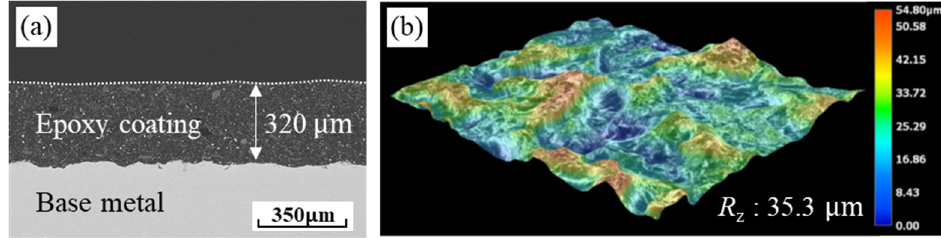
Figure 1. ( a ) The cross-sectional image of the specimen and ( b ) the topographic color distribution and roughness of the base metal before painting.